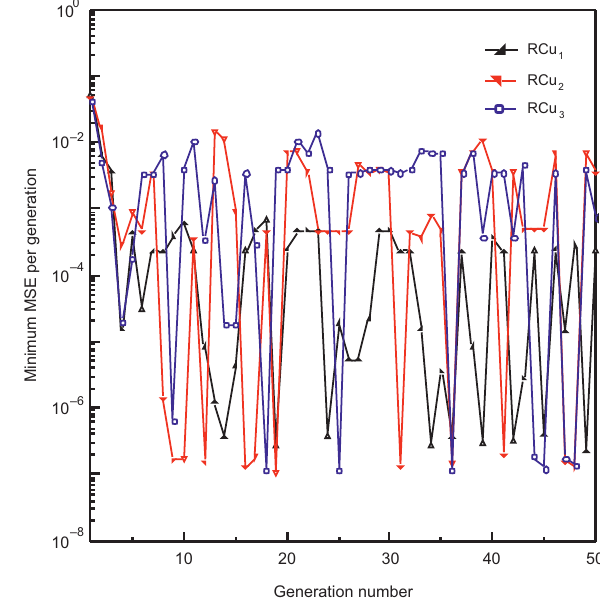
Figure 9. Variation of generation